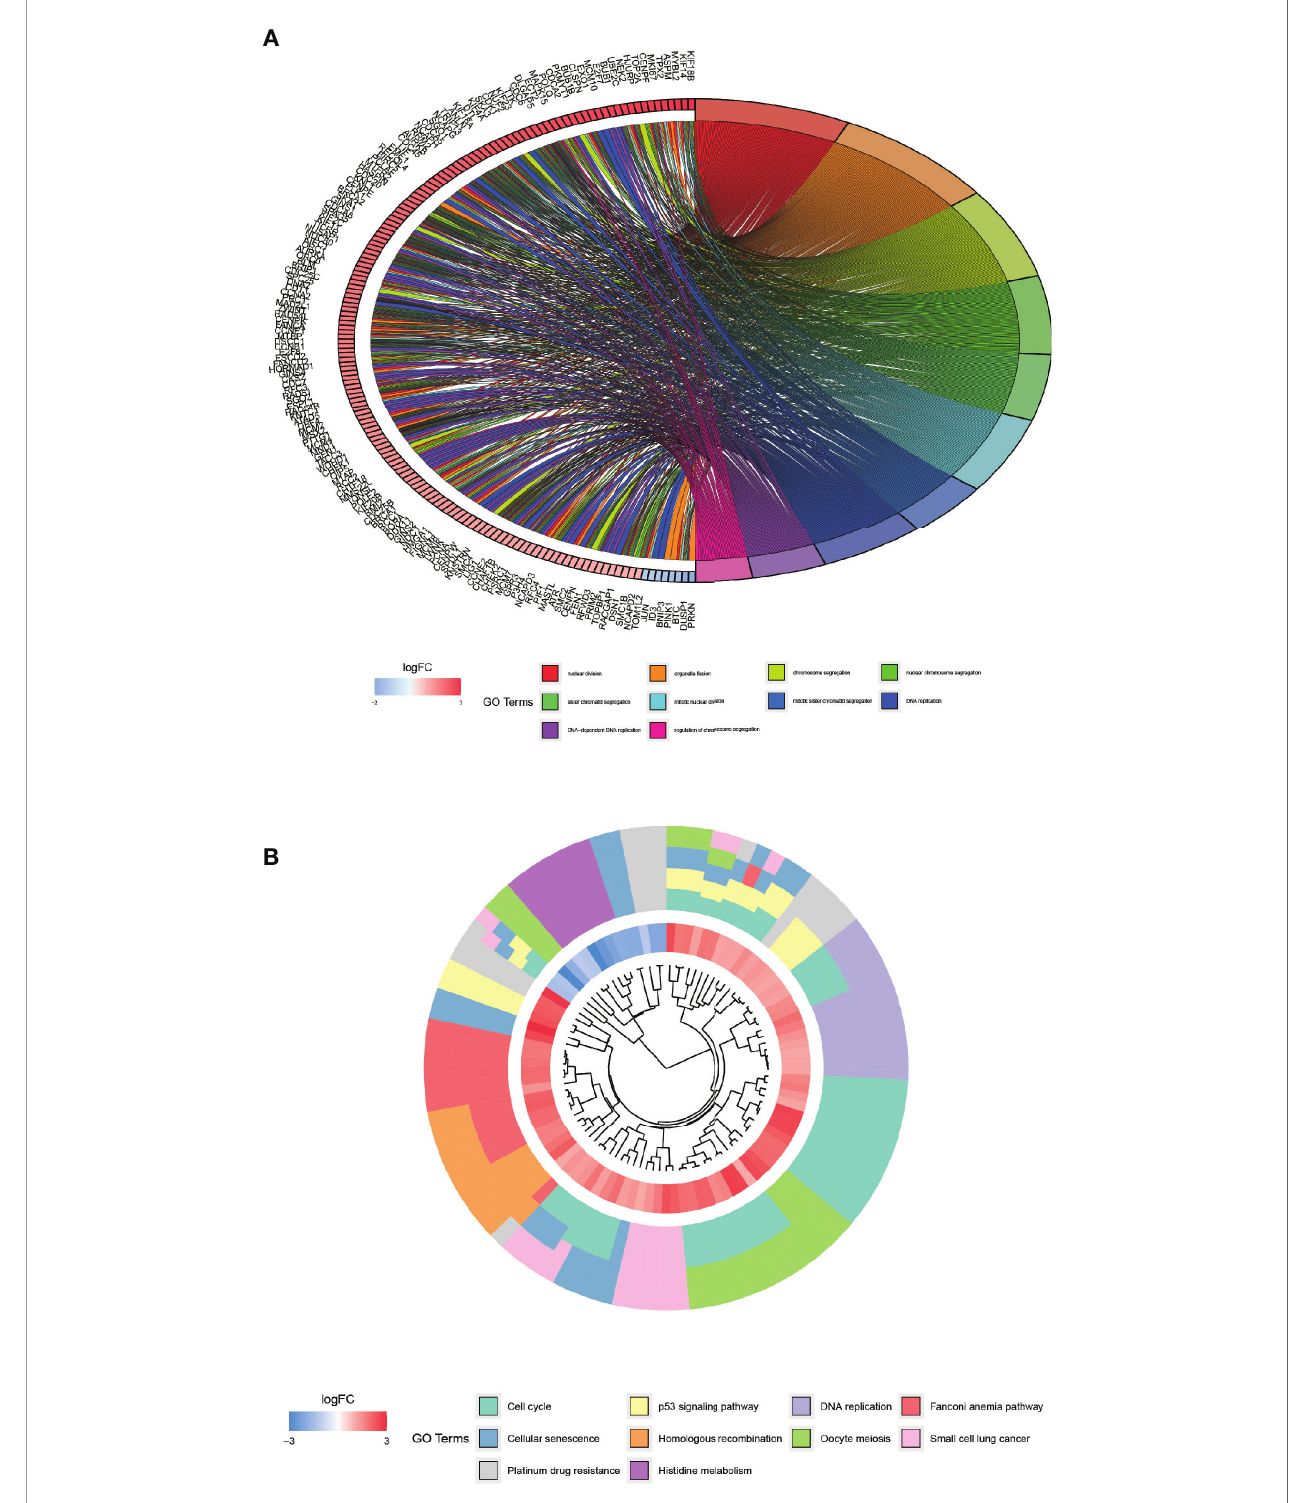
FIGURE 4 | GO enrichment analysis of co-expressed differential genes and KEGG pathway enrichment analysis. Graph (A) showing the fi rst 10 GO entries, with each color indicating one entry and the difference in the color of the gene indicating the change in LogFC value. (B) -plot, KEGG pathway enrichment analysis. Each color indicates a pathway, and the innermost circle indicates the logFC